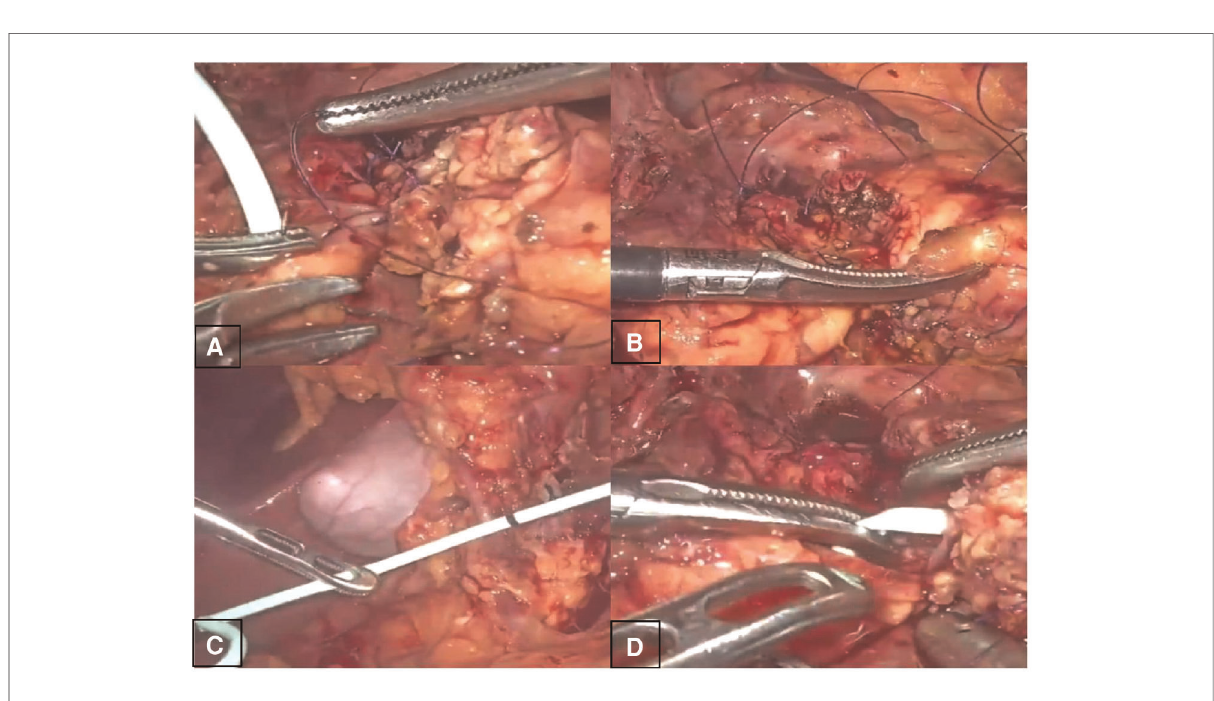
FIGURE 4 Laparoscopic central pancreatectomy (involving A , B , C , D four